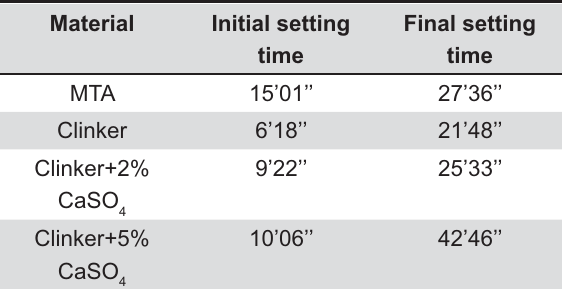
Table 3- (cid:2) (cid:3)(cid:4)(cid:5)(cid:6)(cid:2) (cid:9)(cid:21)(cid:2) (cid:12)(cid:6)(cid:12)(cid:11)(cid:12)(cid:5)(cid:20)(cid:2) (cid:5)(cid:6)(cid:15)(cid:2) =(cid:6)(cid:5)(cid:20)(cid:2) (cid:7)(cid:4)(cid:11)(cid:11)(cid:12)(cid:6)<(cid:2) (cid:11)(cid:12)(cid:18)(cid:4)(cid:7)?(cid:2) (cid:22)(cid:5)(cid:20)(cid:14)(cid:4)(cid:7)(cid:2) expressed in minutes (’) and seconds